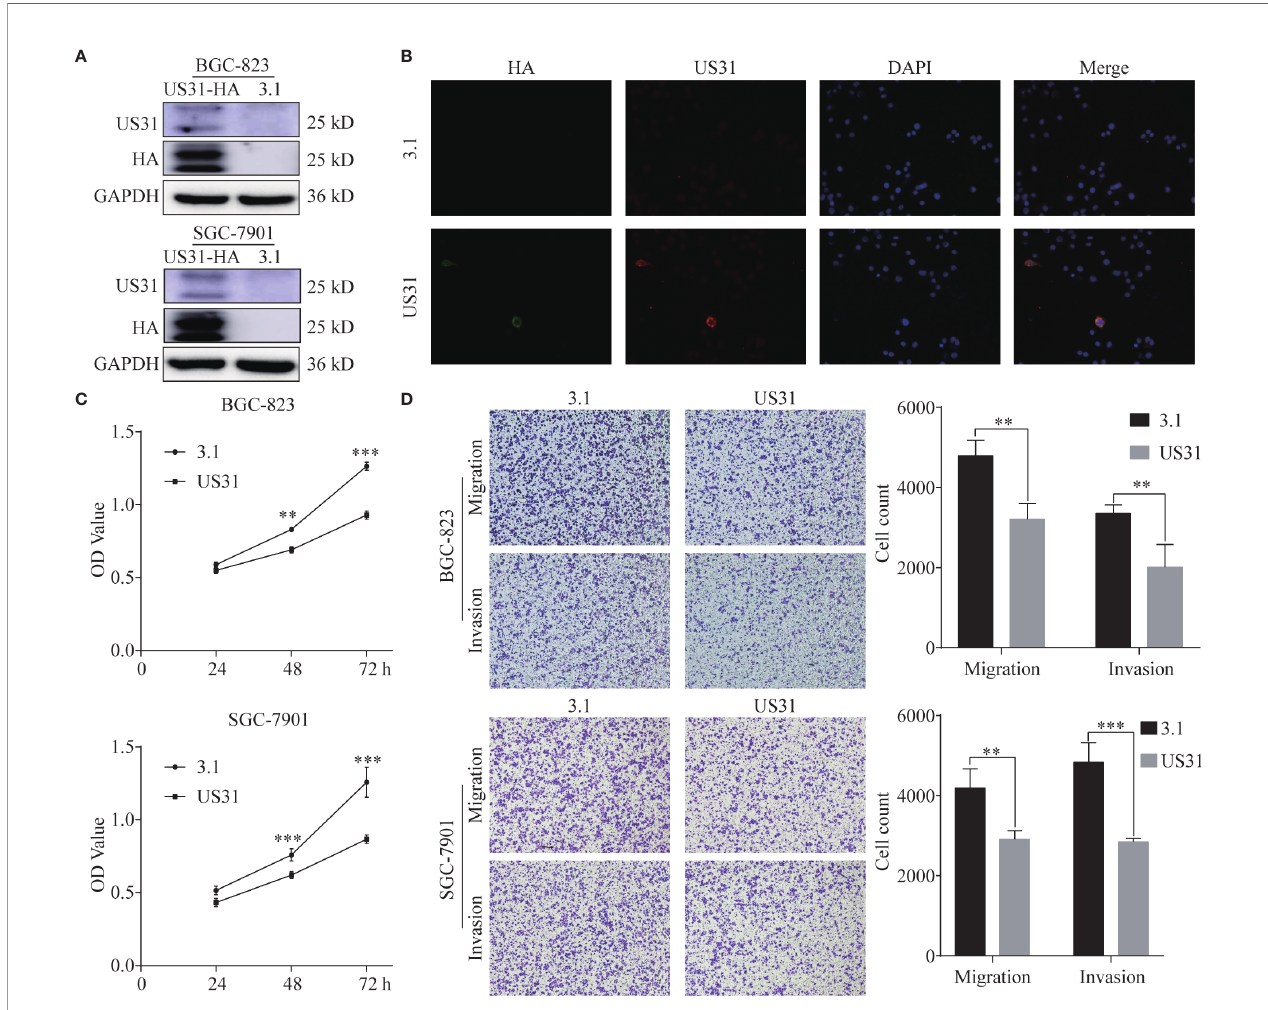
FIGURE 2 | Overexpression of US31 signi fi cantly inhibits the proliferation, migration, and invasion of gastric cancer (GC) cells. (A) Overexpression of US31 in BGC- 823 and SGC-7901 cells. (B) Immuno fl uorescence was used to detect the expression and location of US31 in GC cells. Green fl uorescence represents the HA-tag; red fl uorescence represents US31. US31 is mainly expressed in the cytoplasm and cell membrane. (C) The CCK-8 assay shows that US31 overexpression inhibits the proliferation of GC cells. (D) The Transwell assay shows that US31 overexpression inhibits the migration and invasion of GC cells. **P < 0.01 and ***P < 0.001. ns, no signi fi